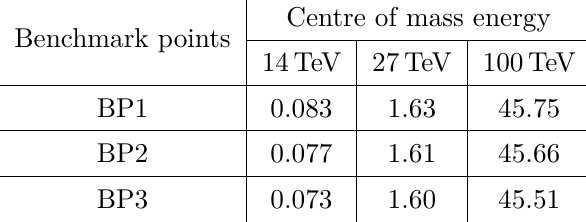
Table 3. Drell-Yan cross-section in fb for p p → N N for the three generations at LHC. We calculate it with three different center of mass energies, 14 TeV , 27 TeV and 100 TeV for chosen benchmark